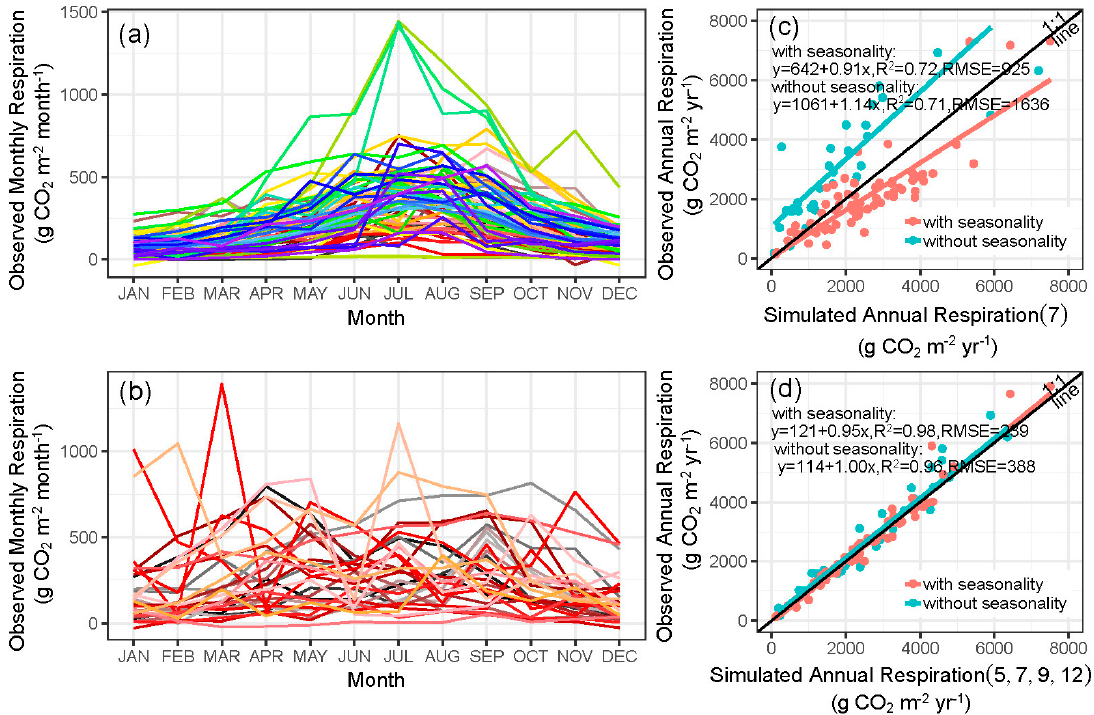
Figure 9. Agreement between simulated and observed annual soil / ecosystem respiration of data with or without a seasonal pattern. ( a , b ) are monthly variation of respiration with and without a seasonality, respectively. The respiration with one peak across a year was categorized as the with-seasonality group, whereas the respiration presenting several peaks or no obvious peak across a year was categorized as the without-seasonality group. ( c , d ) are simulation verification of respiration with or without seasonality, using one and four monthly respirations, respectively. The simulated respirations in ( c , d ) were derived using Equations (B1) and (B4) in Table 3, respectively.